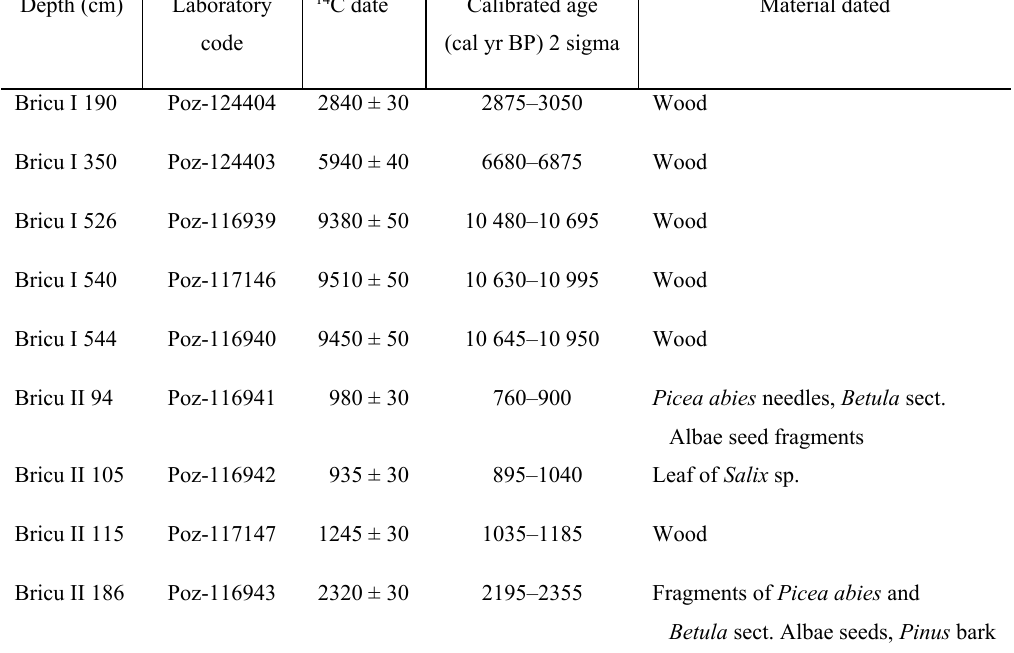
Table 1. Radiocarbon ages for Lake Bricu sediment